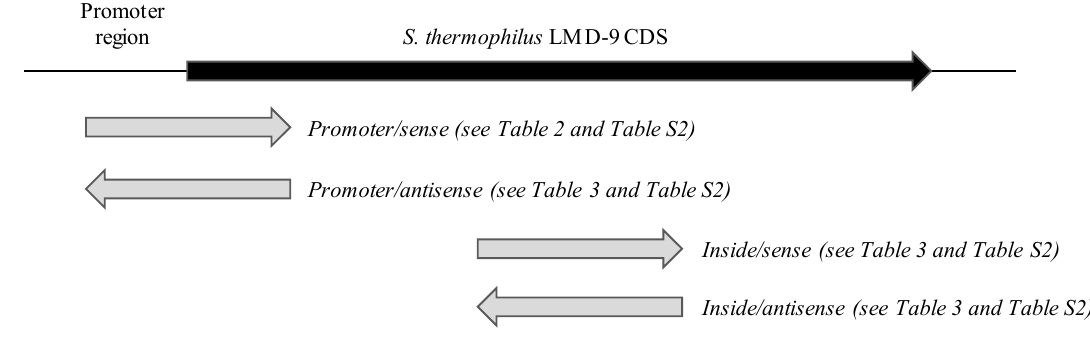
Figure 5. Location, orientation, and denomination of inserts of activated R-IVET clones compared to S. thermophilus LMD-9 genes. CDS: coding DNA sequence.